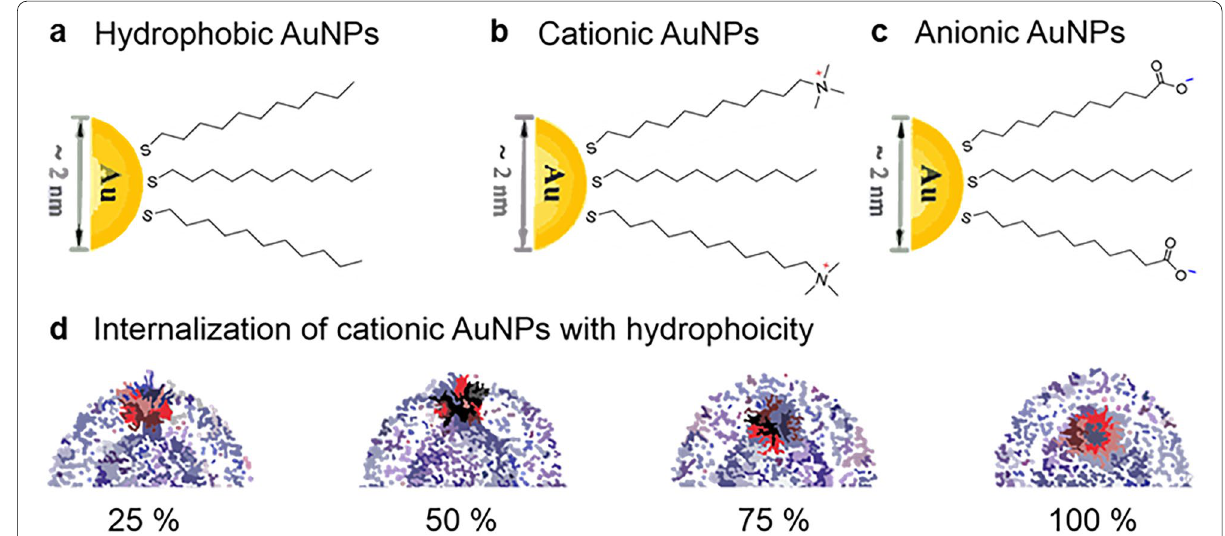
Fig. 4 Schematic illustration AuNPs decorated with different surface ligands and their interaction with synthetic vesicles. Schematic diagram of AuNPs coated with a hydrophobic ligand, b cationic ligand, and c anionic ligand. d Simulation snapshot of the AuNPs coated with hydrophobic and cationic ligands entering the lipid membrane